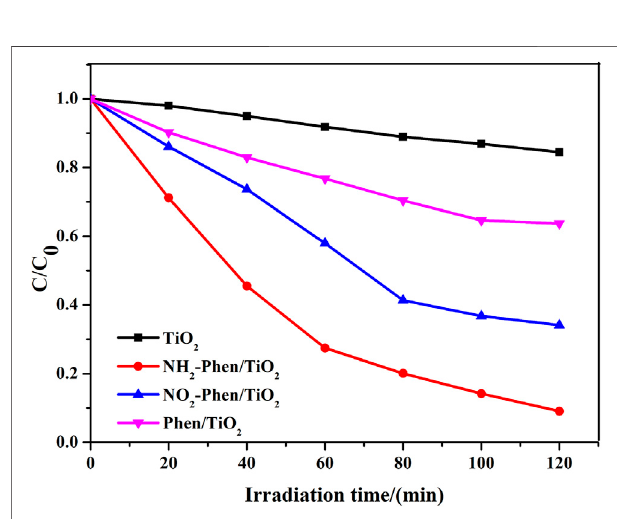
FIGURE2| PhotoreductionofMOovertheas-preparedmaterialsunder visible light (70 mg catalysts and 70 ml MO solution with a concentration of 10